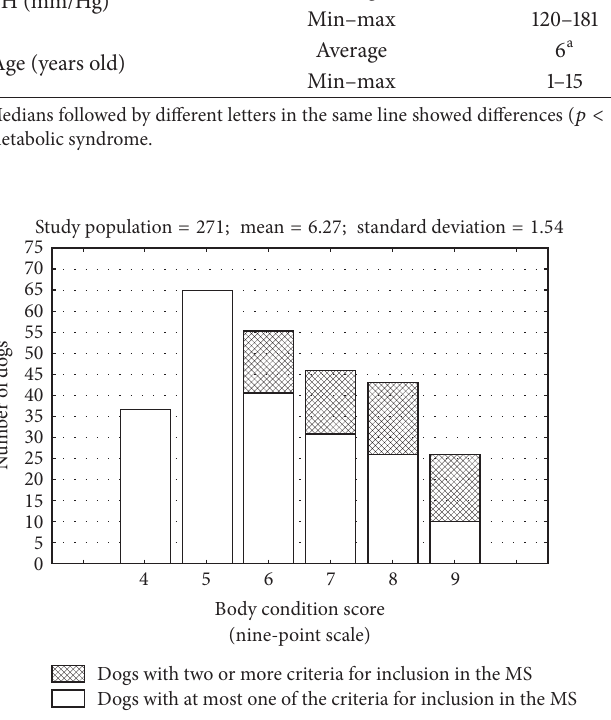
Figure 1: Absolute frequency of 271 dogs grouped according to the BCS and separated according to the number of criteria used for inclusion in the metabolic syndrome